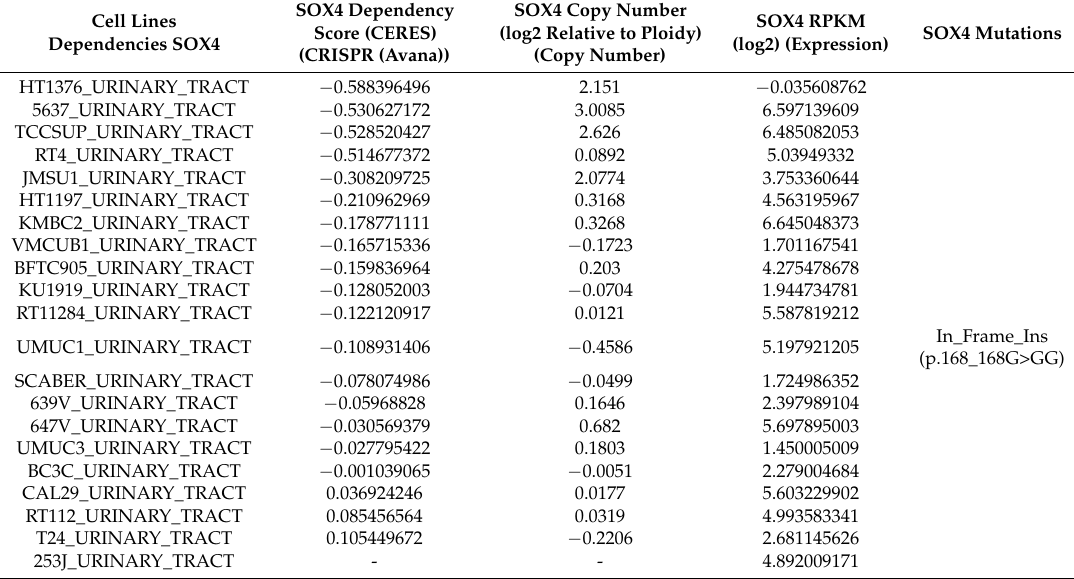
Table 1. SOX4 dependencies, based on CERES score—CRISPR Avana: SOX4 overexpression and high CN: 5637, TCCSUP; SOX4 overexpression, NO amplification: RT4; SOX4 amplification, NO overexpression: